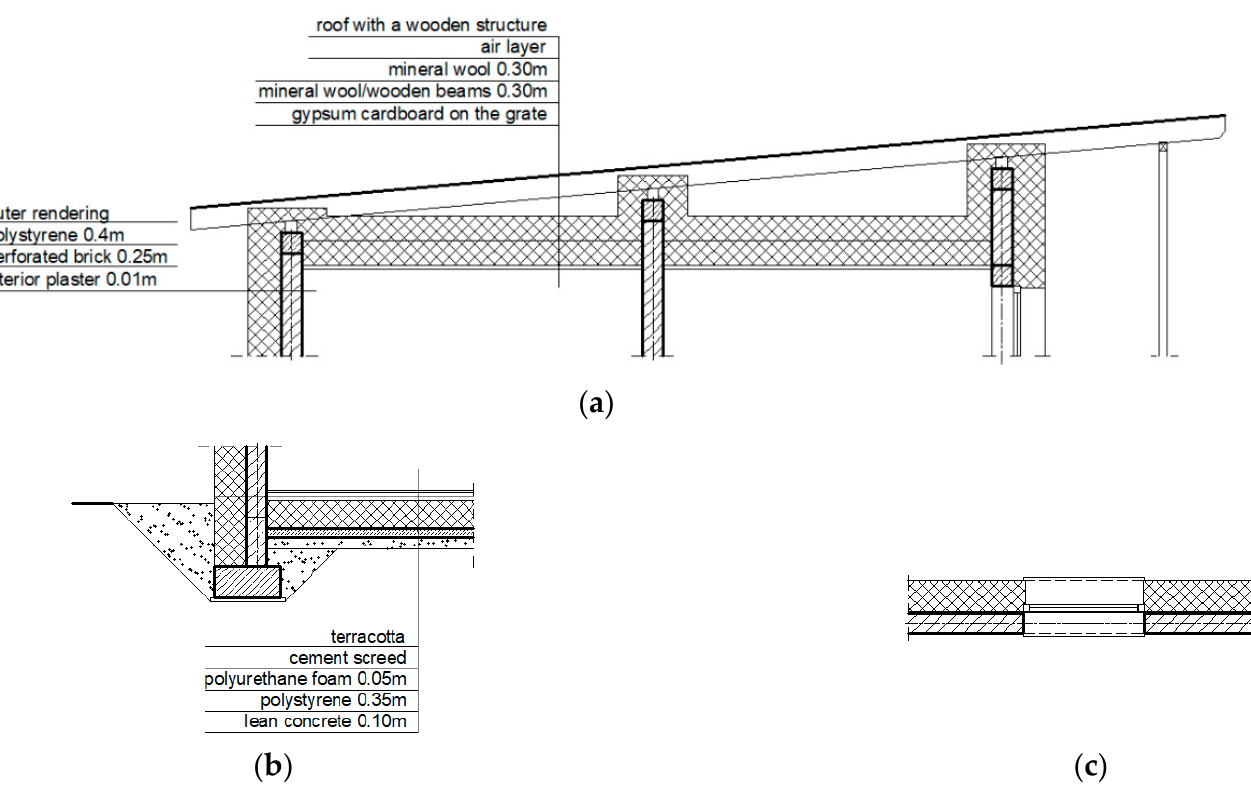
Figure 7. Construction of the building envelope: ( a ) roof in connection with external walls; ( b ) connection of the wall with the floor slab; ( c ) installation the window in wall.